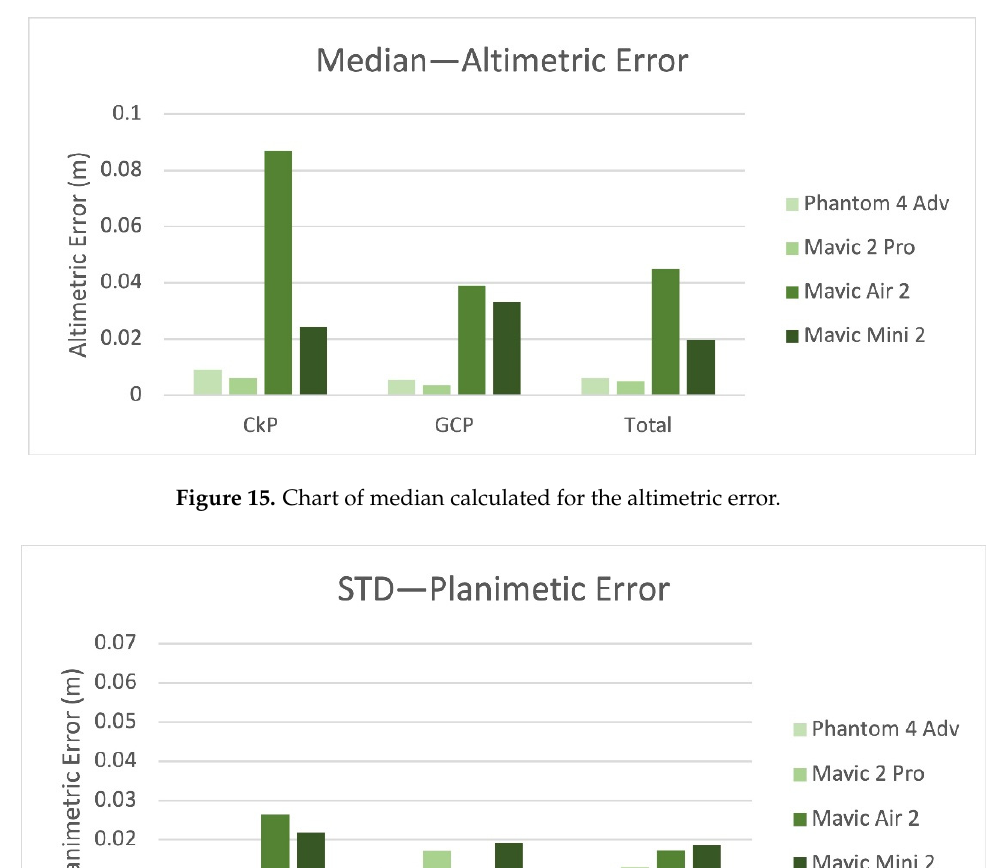
Figure 14. Chart of median calculated for the planimetric error.